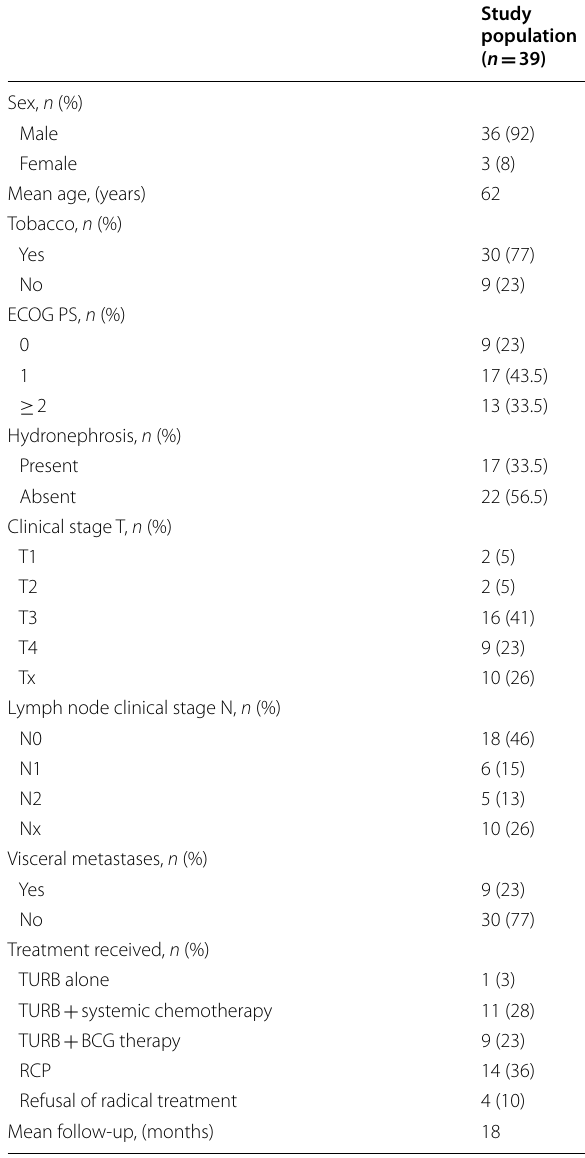
Table 1 The clinical characteristics of the patients in our